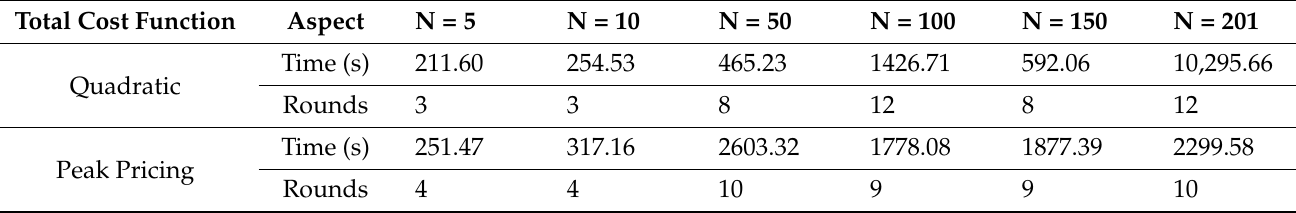
Table 4. BRD solution times when changing the number of consumers.